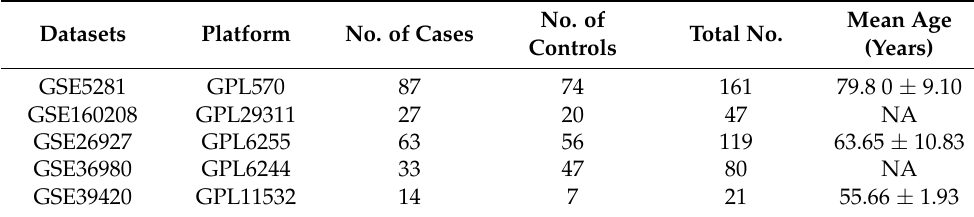
Table 1. Characteristics of the subjects and the microarray datasets included in this